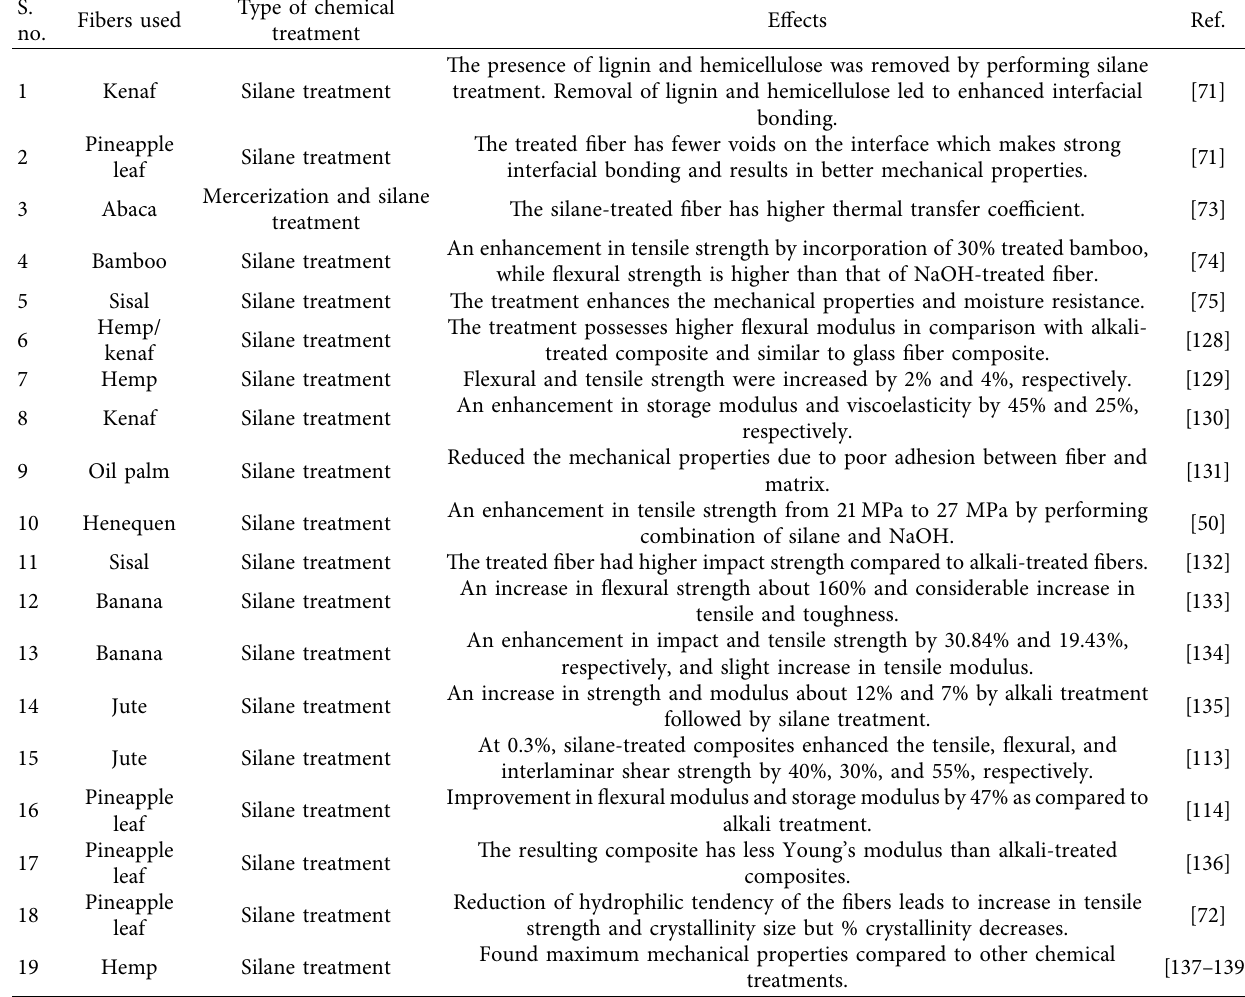
Table 2: Effect of silane treatment on various biofibers.